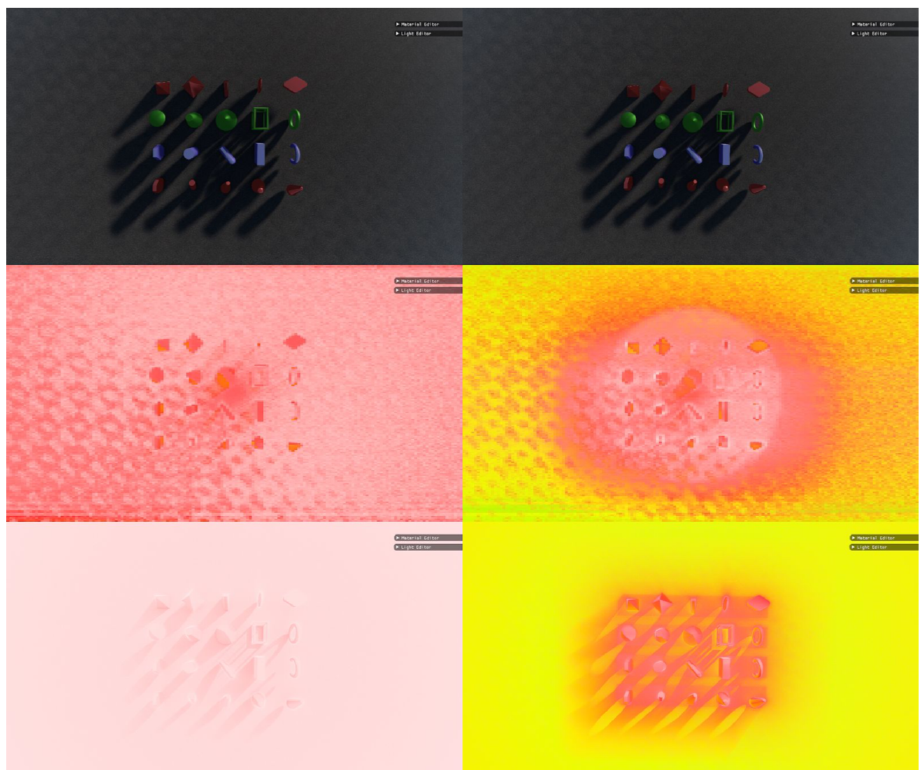
Figure 8. A comparison of the performance difference between bounding volume optimisation being enabled ( right ) and disabled ( left ). The views shown are the final pass ( top ), kernel clock cycles ( middle ), and SDF evaluation count per pixel ( bottom